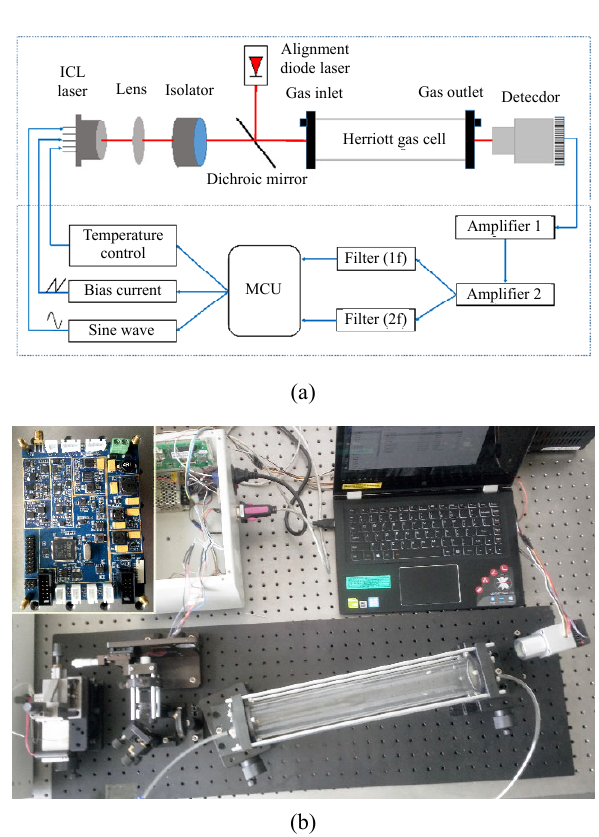
Fig. 2 Architecture of ethanol sensor: (a) experimental schematic of the ethanol sensor and (b) photo of the sensor platform and integrated circuit